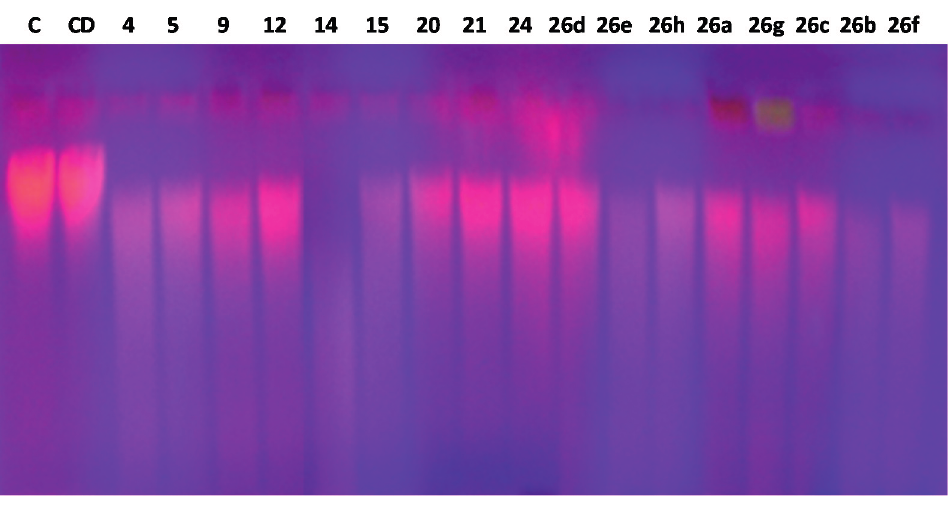
Figure 1. A figure showing the degradation effect of 4 μ g of series (Lanes 3–19) on the genomic DNA isolated from E. coli , Lane1 E. coli DNA and lane 2 E. coli DNA +